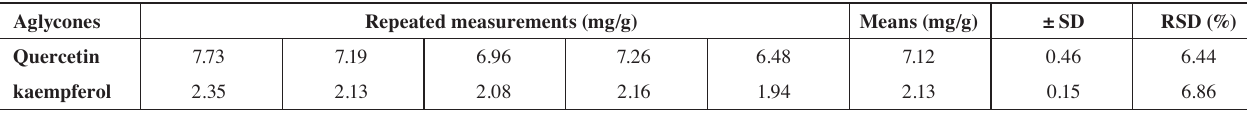
Tab. 2: Reproducibility for the determination of the two aglycones by the UAHAE method